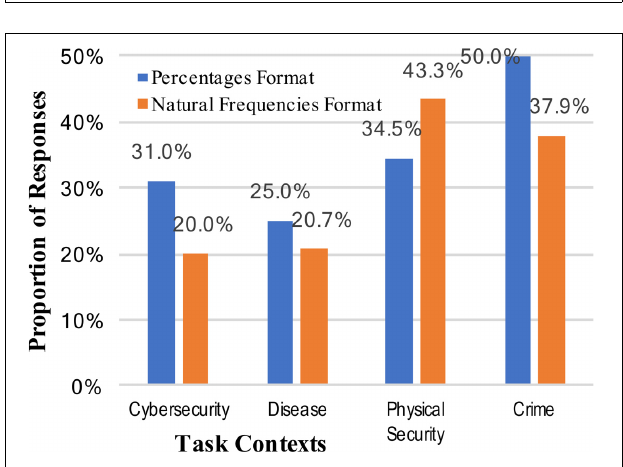
FIGURE 4 | Percentages of participants who reached the correct posterior probability answer to the Bayesian reasoning task (1 out of 2, or 50%), across the context stories and numerical format conditions.